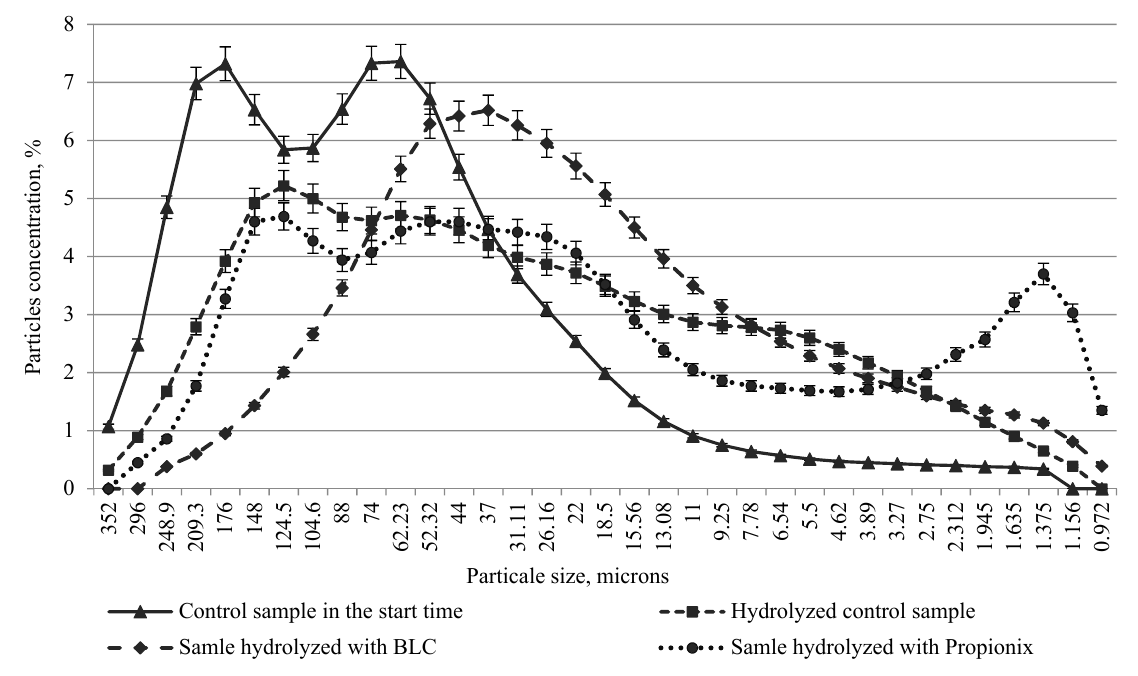
Figure 6. Particles size distribution in the samples of hen comb hydrolysates. Table 2. Average hydrodynamic diameter determined from the numerical particle size distribution in hydrolysates.